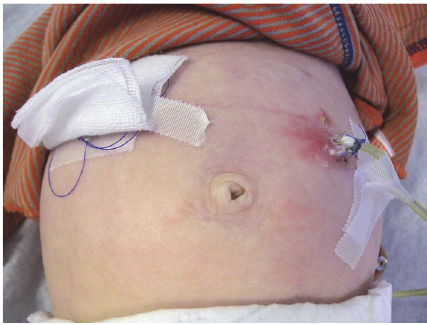
Figure 13: Local skin infection at the site of the jejunostomy. This infection was treated with antibiotic ointment and enterally administered